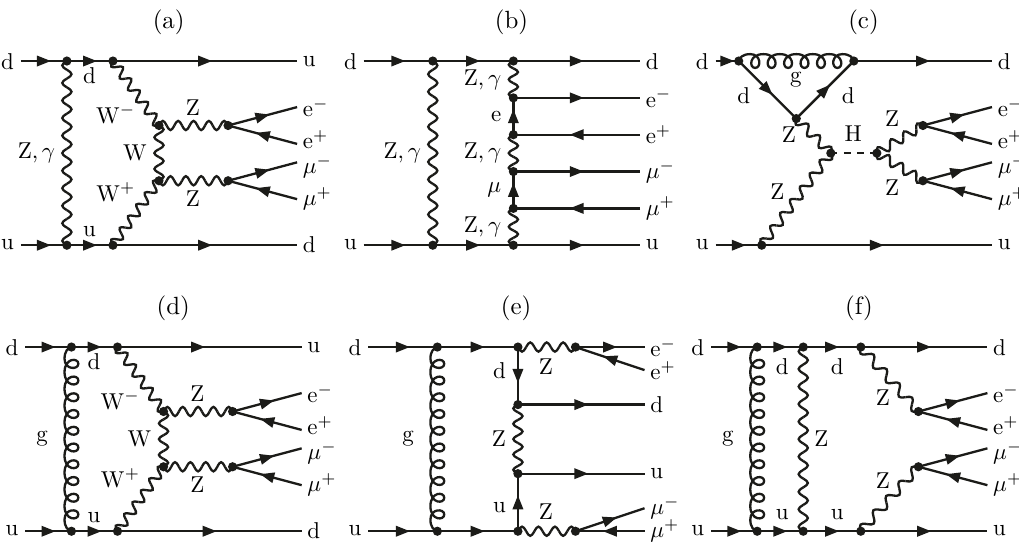
Figure 3. Sample one-loop